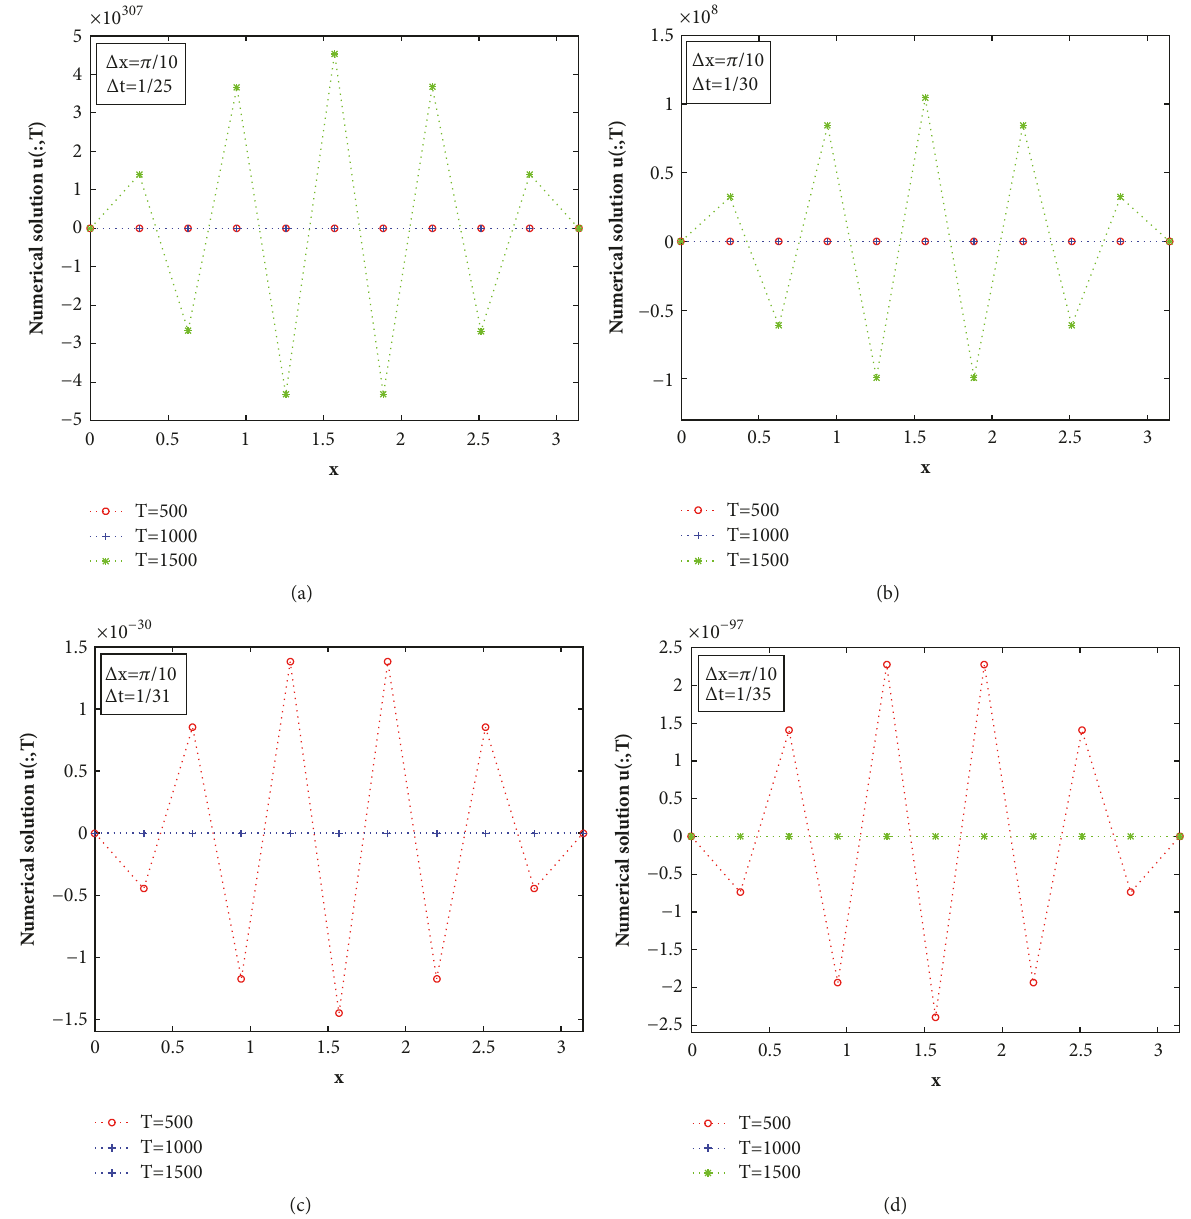
Figure 1: Numerical solution at the different final time T for varying parameter 𝑚 ( 𝜃 = 0 and 𝜏 = 1 ). (a) 𝑚 = 25 . (b) 𝑚 = 30 . (c) 𝑚 = 31 . (d) 𝑚 = 35